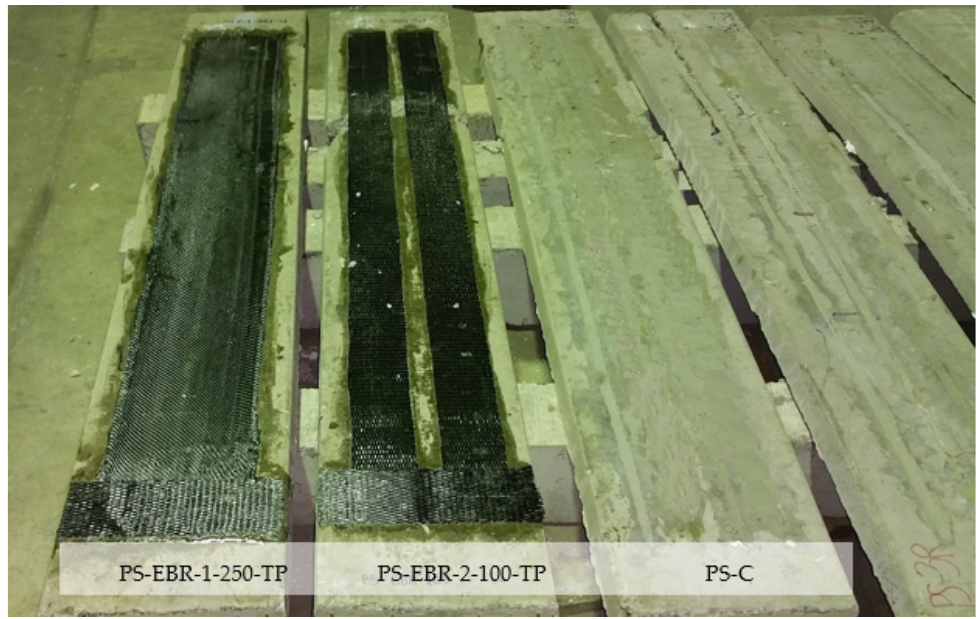
Figure 4. Application of EBR CFRP sheets at the slab’s soffit (PS-EBR-2-100).